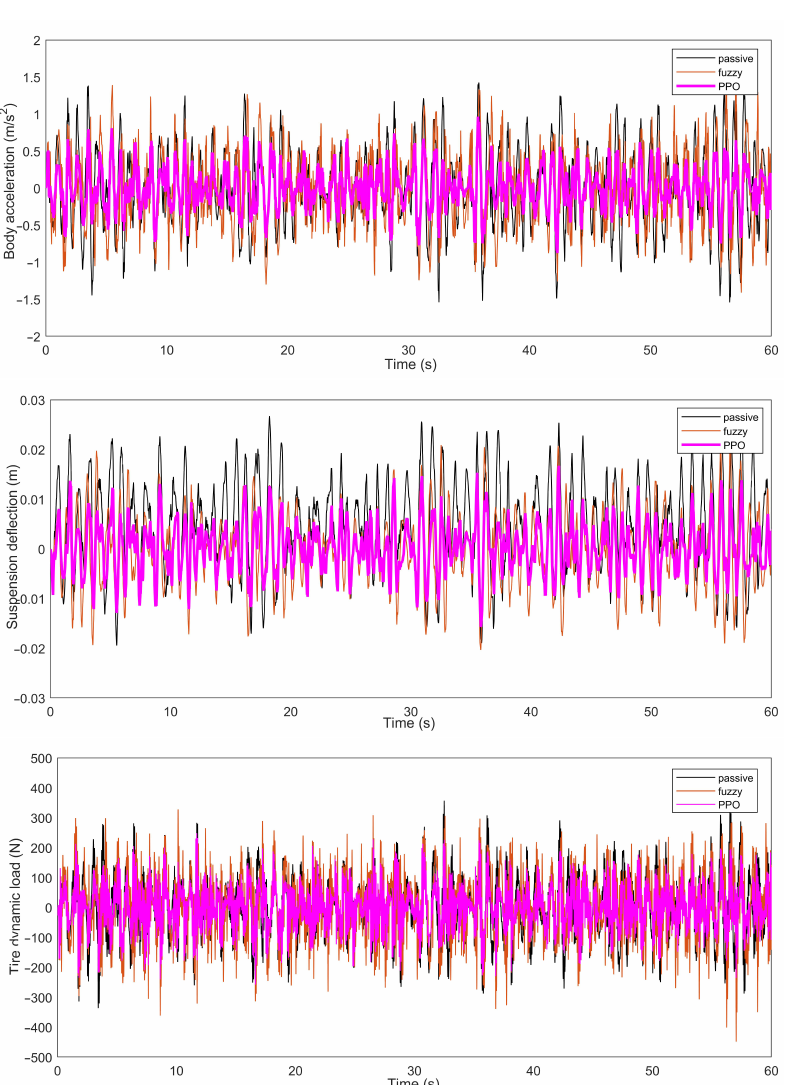
Figure 6. Simulation results of fuzzy, PPO, and passive suspension systems for a light vehicle on a C-class road.